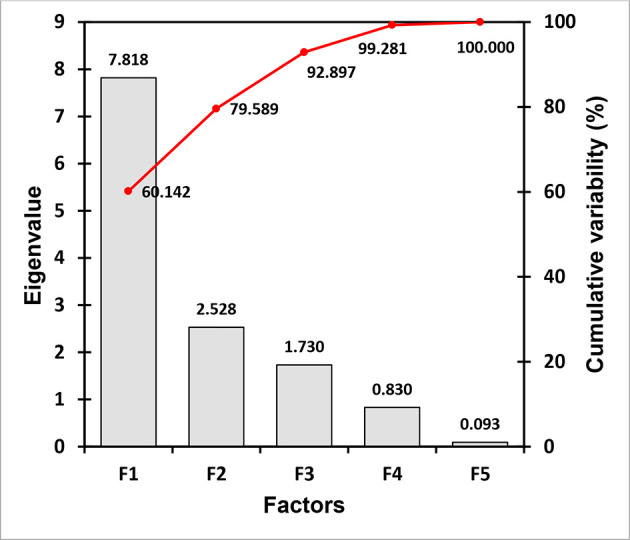
Scree plot showing the first three factors for most of the cumulative variability in data represented by the eigenvalues.